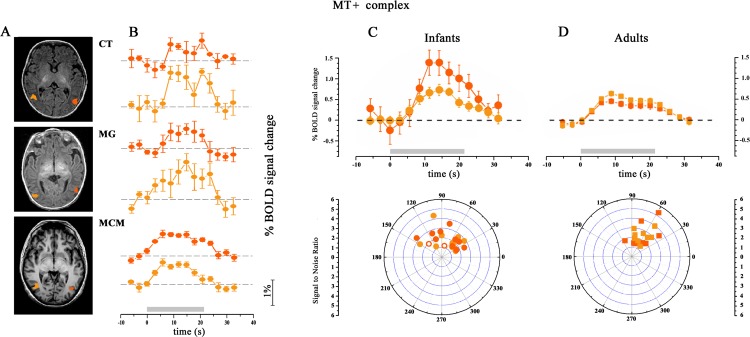
Localization and BOLD responses of complex MT+.A: Example of localization of complex MT+ in two infants (CT and MG) and one adult (MCM; bottom row) in response to coherent- versus random motion (threshold at p ≤ 0.01). Images in radiological convention. B: time-courses of the individual ROI in A for the right (light orange) and left (orange) hemispheres, averaged over 4 and 5 periods for CT and MG respectively. The grey bar indicates the duration of coherent motion. C- top: Time-course averaged across all infants for the right (light orange) and left (orange) hemispheres of MT+ (bars ±1 standard error of the mean [sem]). C-bottom: reliability of responses of individual infant MT+. The distance from the origin indicates the Signal to Noise (S/N) ratio evaluated as the ratio between the amplitude of the fundamental frequency to the mean square root of the amplitude of the adjacent frequencies. The angle reports the phase of the fundamental frequency response (in degree). A phase of 64° corresponds to a standard hemodynamic delay. D. Same convention as C for adult subjects. Filled symbols correspond to p < 0.01, open to 0.01 < p < 0.05 threshold. Note that all infants’ responses have a S/N ratio greater than 1. (MT+: temporo-occipital complex; s: seconds.) Numerical data are available in the S1 Data, Fig 1.